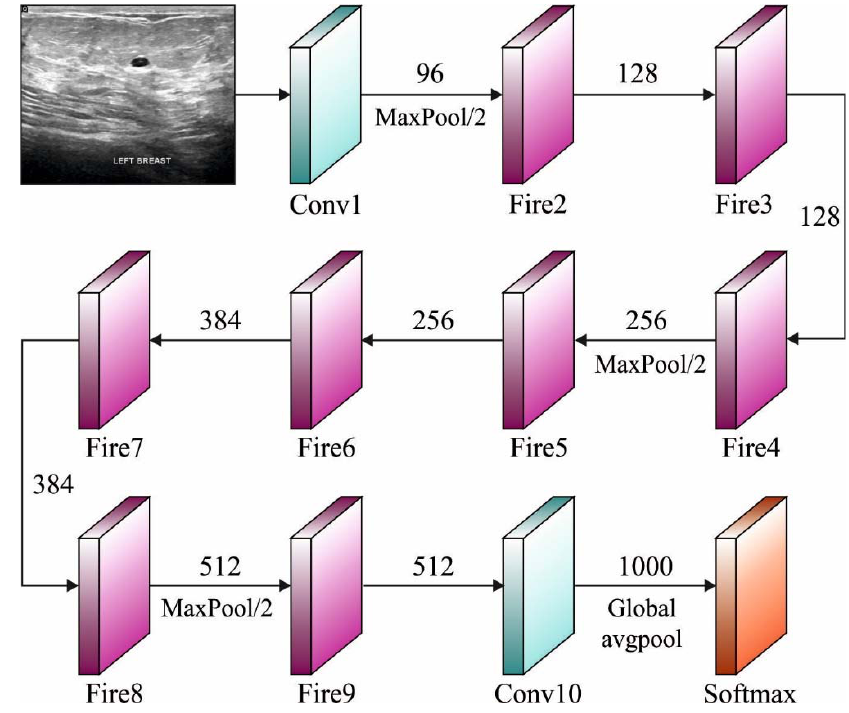
Figure 2. SqueezeNet architecture.